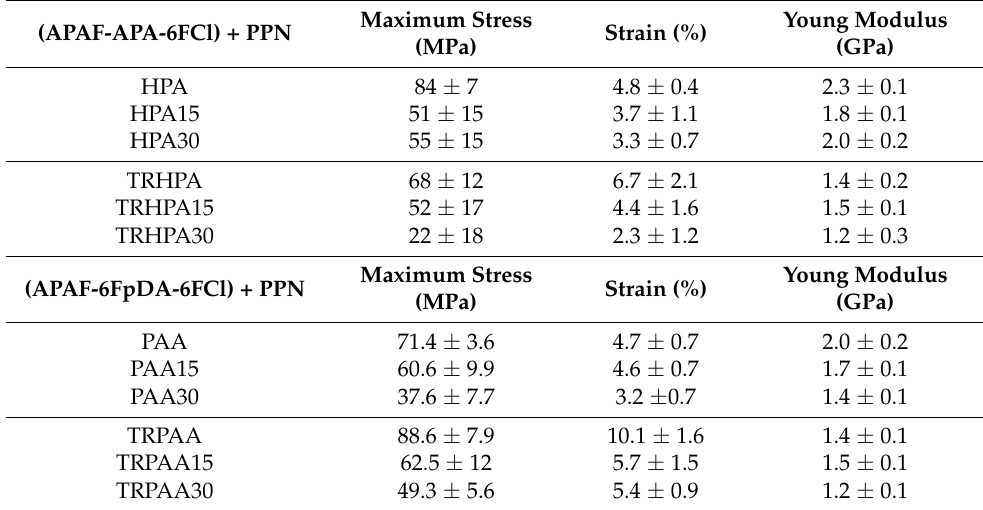
Table 4. Mechanical properties of the pristine and MMM